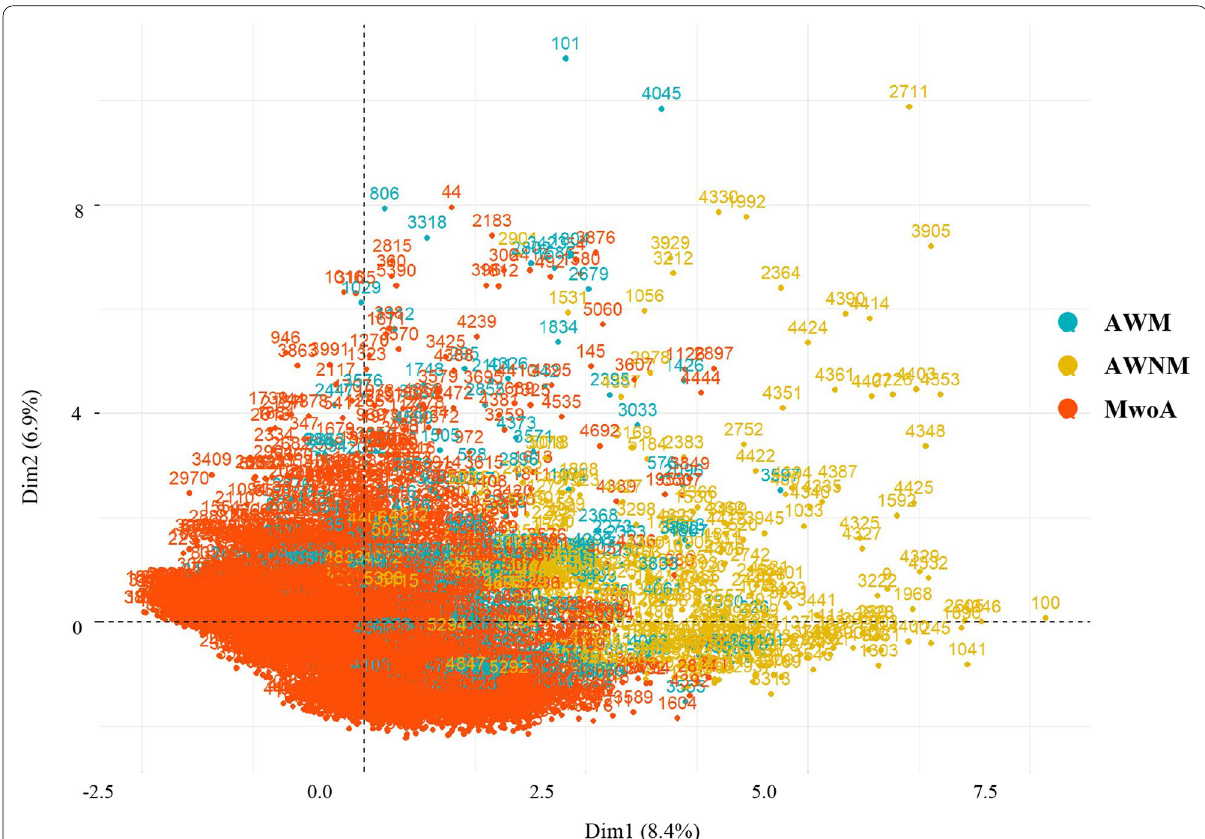
Fig. 5 Graphical results of the factor analysis for mixed data (FAMD). The x- and y-axes represent the 2 first dimensions of the FAMD (these 2 dimensions explained 15.3% of the point variability). Subjects were subdivided into three separate clusters (red, green, and yellow dots), which represented three subtypes of migraine (MwoA, AWM, and